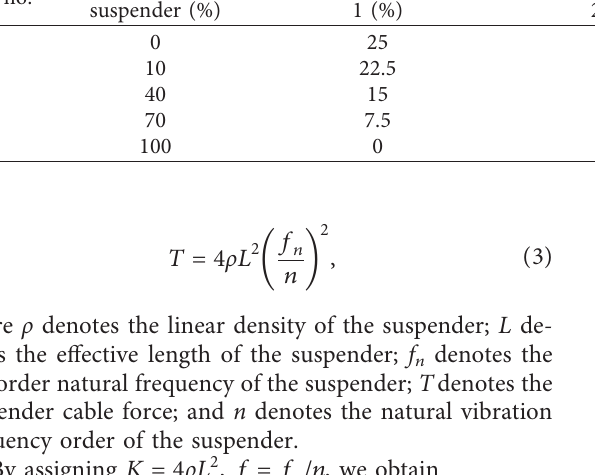
Table 6: Conversion relationship between new suspender cable force and temporary suspender under loading. Step